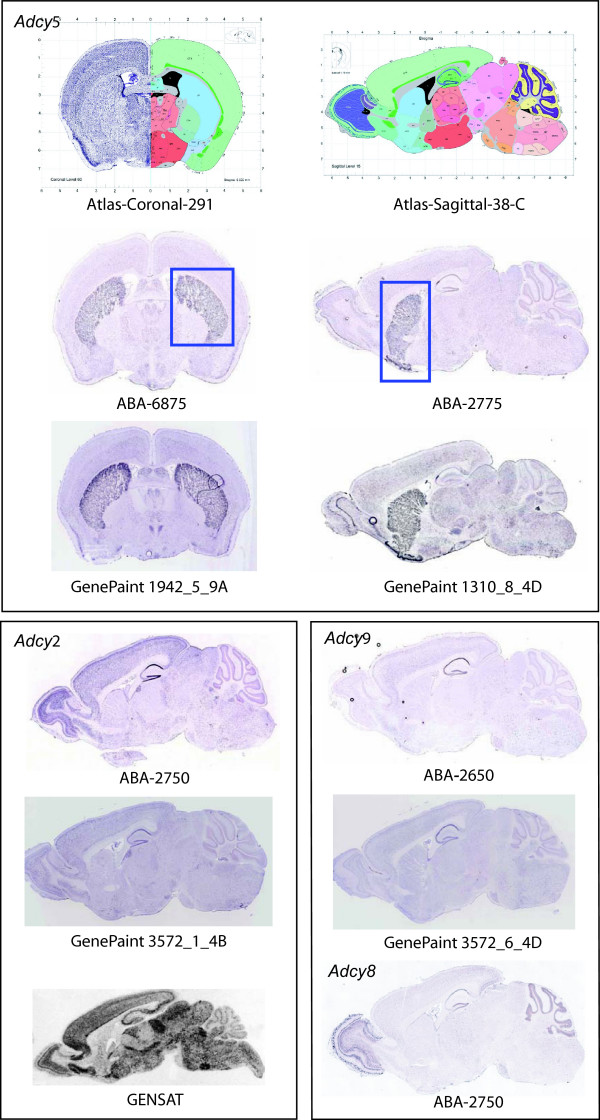
Spatial gene expression patterns of various adenylyl cyclase isoforms. Adcy5 is predominantly expressed in mouse striatum, while Adcy2, Adcy8, and Adcy9 show substantially different expression patterns. Brain images were obtained from the ABA, GenePaint.org, and GENSAT databases. The striatum region in ABA-6875 and ABA-2775 is outlined by a blue box.